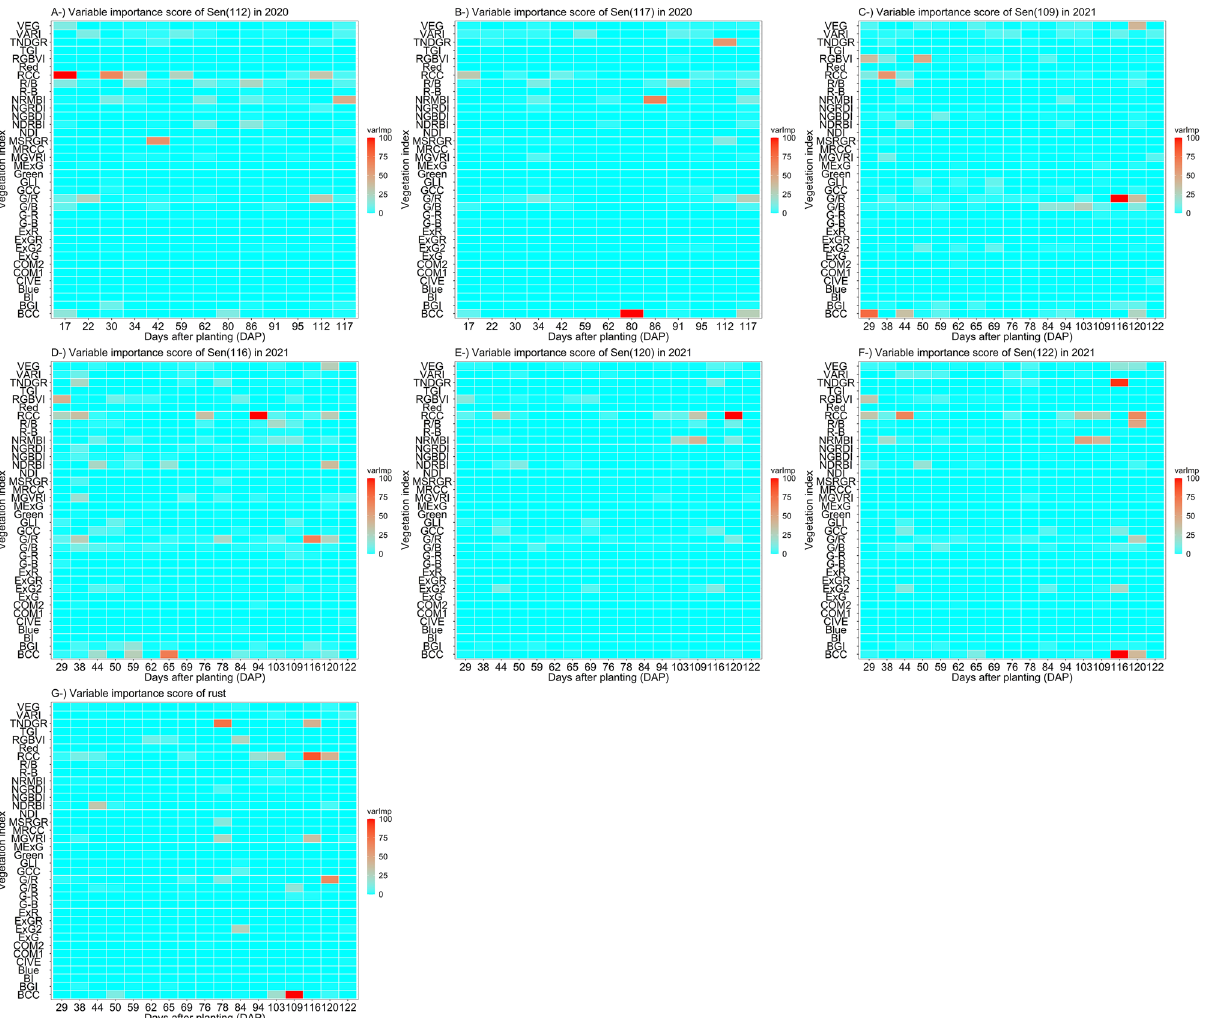
Figure 10. Variable importance scores ( varImp ) scores of 2020 and 2021 phenomic data for two and four senescence scores in 2020 and 2021 respectively, and rust in 2021 obtained by lasso algorithm. Each plot denotes variable importance scores according to the following naming: ( A ) senescence at 112 days after planting (DAP) in 2020; ( B ) senescence at 117 DAP in 2020; ( C ) senescence at 109 DAP in 2021; ( D ) senescence at 116 DAP in 2021; senescence at 120 DAP in 2021; senescence at 122 DAP in 2021; rust in